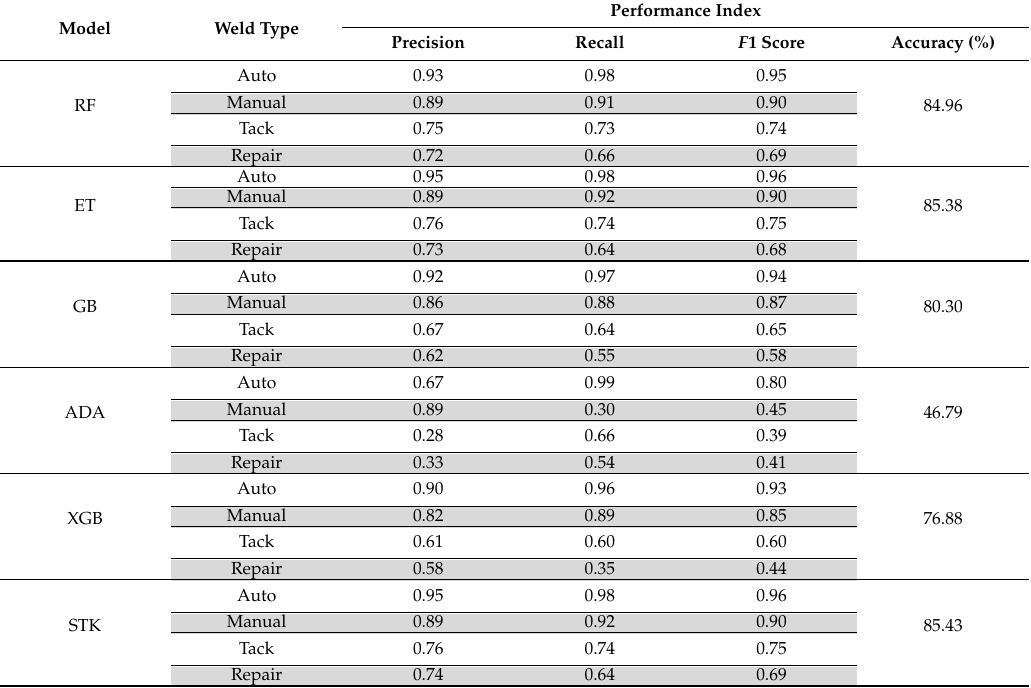
Table 10. Model performance by